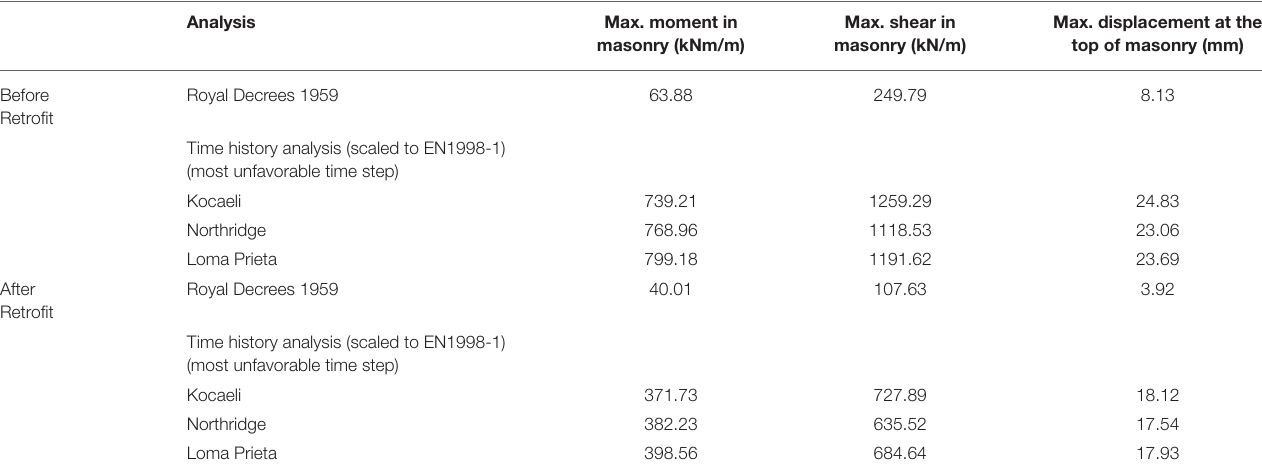
TABLE 3 | Comparison of forces and displacements for the studied cases of seismic analysis, while moment capacity is of the range of 250 kN m/m and shear capacity is of the range of 120 kN/m (depends of the exact dimensions of each masonry unit).